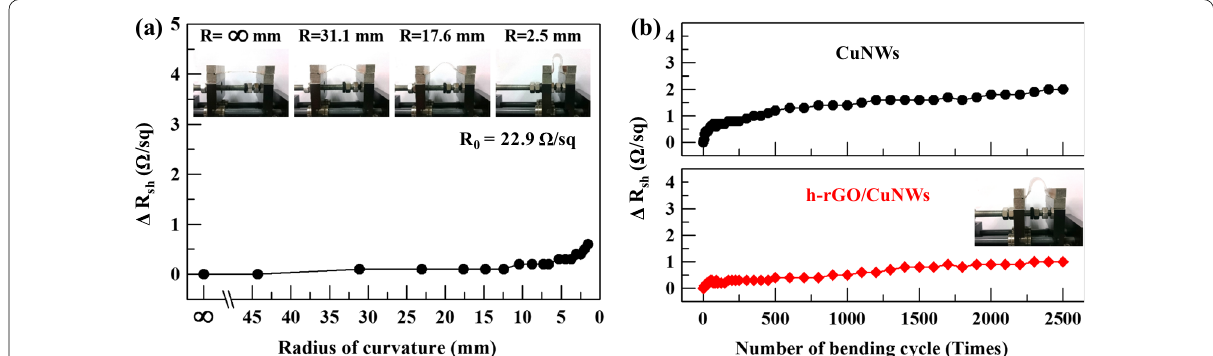
Fig. 6 a Sheet resistance as a function of the radius of curvature of the h‑rGO/CuNWs film. b Variation in the sheet resistance of the CuNWs and h‑rGO/CuNWs films on the PET substrate as a function of bending cycles. The films were bent to a radius of curvature of 5.3 mm, as shown in the